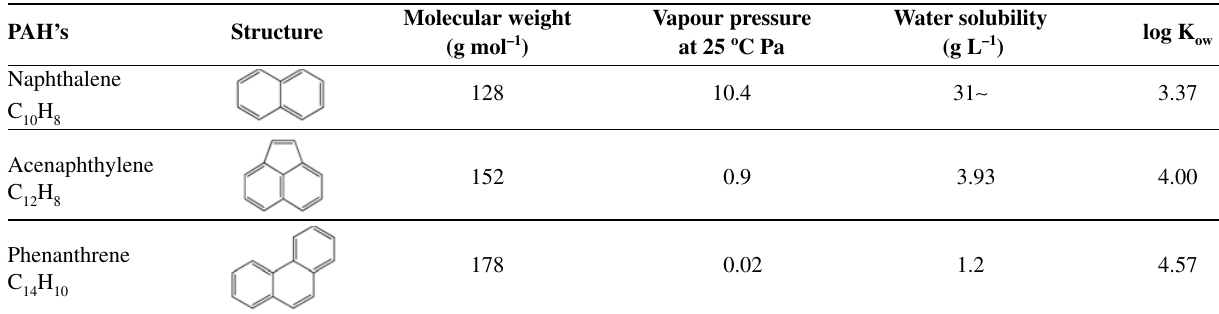
Table 1 . Physicochemical properties of the selected PAHs